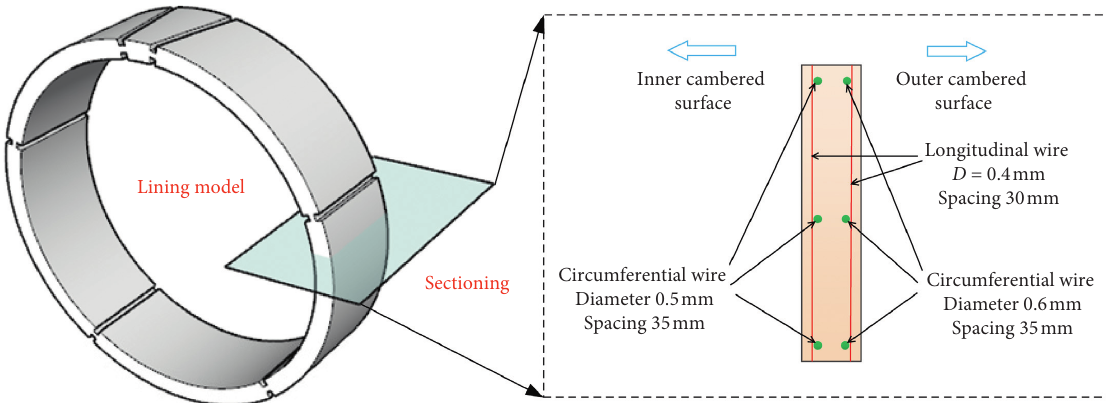
Figure 6: Distribution of the segment reinforcements.